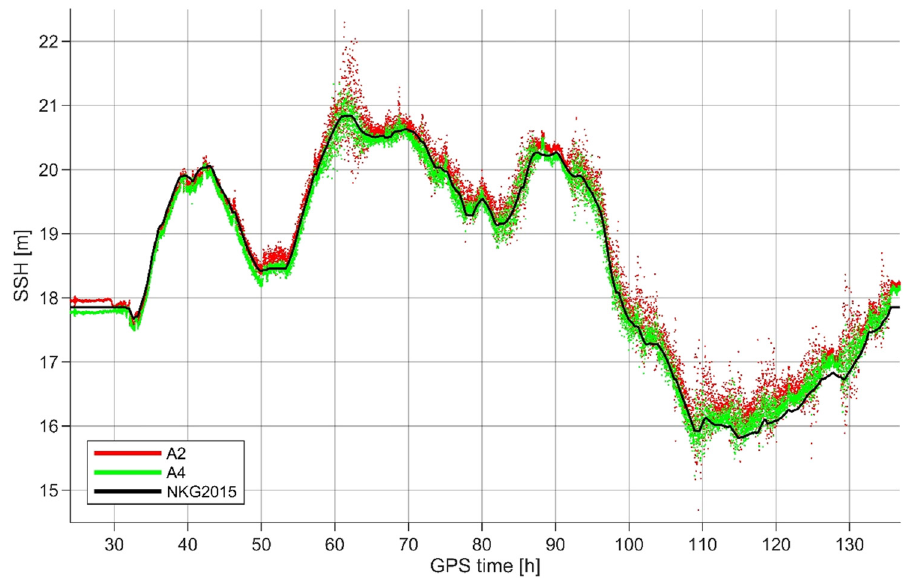
Figure 11: SSH determined by antennas A2 and A4 during the second campaign ( C2 ) . No static draft nor DT corrections are included at this stage of analysis. The black line represents the heights of the NKG2015 quasigeoid model. Note that the time span of 10 h corresponds roughly to 160 km ( ∼ 90 nautical miles )